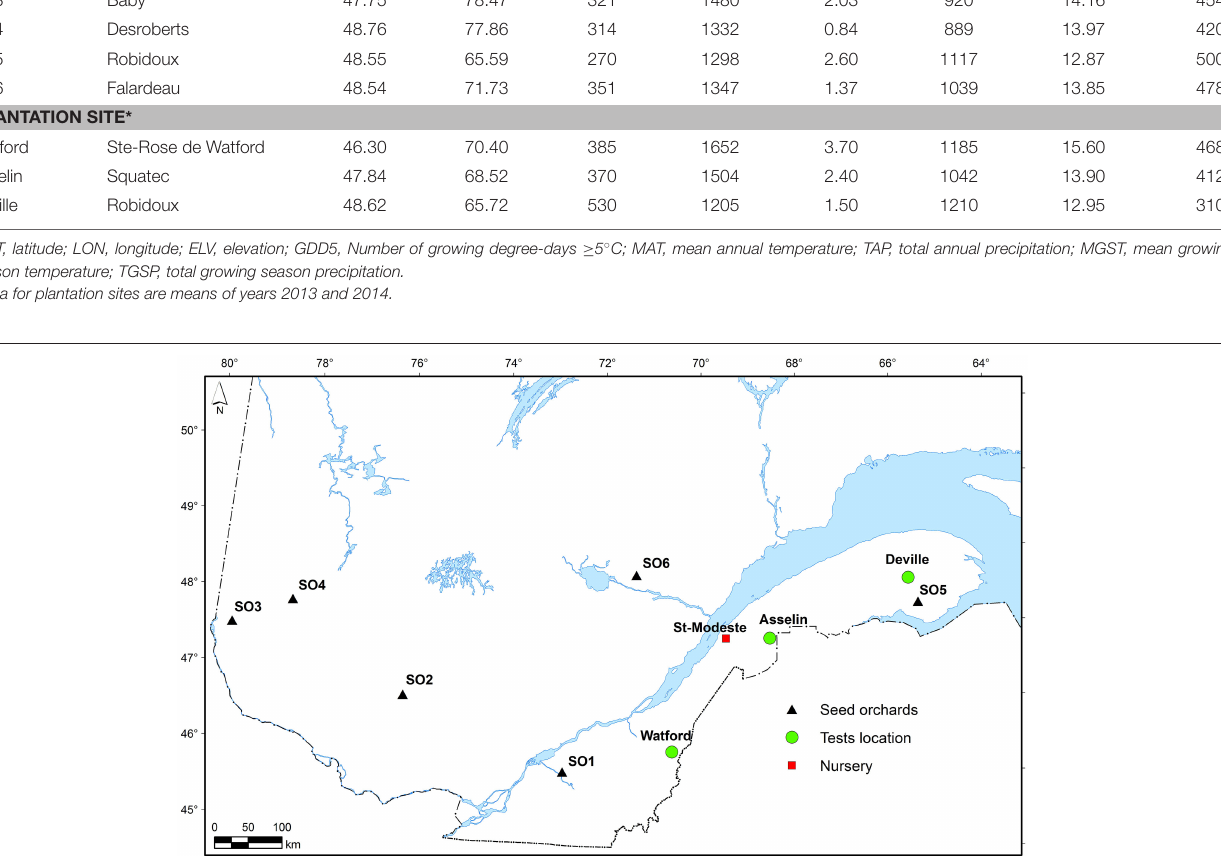
At each site, we chose a randomized complete block design with four blocks each one was partitioned into six plots within which the six seed sources (SO) were assigned randomly. The size of each plot was about 730 m 2 and contained 144 trees (12 × 12 rows of trees) in which the 64 interior trees were considered, leaving 4 × 4 rows of border trees as a buffer